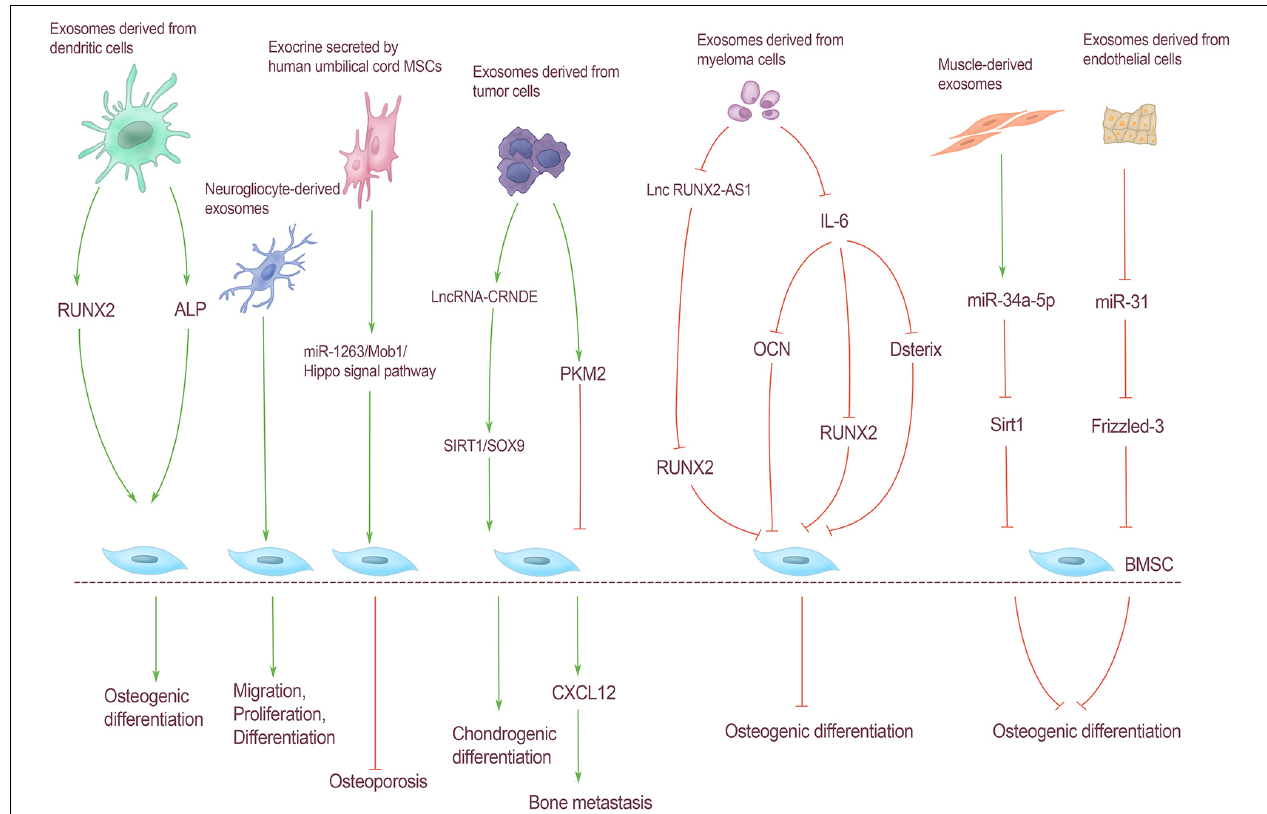
FIGURE 3 | Regulation of BMSCs by exosomes from extra-skeletal organs. Exosomes derived from dendritic cells increased Runx2 expression and ALP activity, and promoted osteogenic differentiation of BMSCs. Neurogliocyte-derived exosomes can promote the migration, proliferation and differentiation of BMSCs. Exosomes secreted by human umbilical cord MSCs can reduce the apoptosis of BMSCs through the miR-1263/Mob1/Hippo signal pathway, and can effectively prevent osteoporosis. Exosomes derived from tumor cells lncRNA-CRNDE can regulate the chondrogenic differentiation of BMSC through SIRT1/SOX9. Exosomes derived from tumor cells act on BMSCs through PKM2, resulting in CXCL12 production in BMSCs, thereby promoting bone metastasis of tumor cells; myeloma cells can directly inhibit RUNX2 by releasing exosomes carrying lnc RUNX2-AS1 through paracrine action on BMSCs, thus inhibiting BMSCs osteogenic differentiation. IL-6 carried by exosomes derived from myeloma cells could inhibit bone differentiation of BMSCs by down-regulating the expression of Runx2, OCN, and Osterix. The expression of miR-34a-5p in muscle-derived exosomes was significantly increased, which could reduce Sirt1 expression and inhibit osteogenic differentiation. Exosomes derived from endothelial cells contain miR-31 into bone through blood circulation and act on BMSCs. Osteoblast differentiation was inhibited by inhibiting Frizzled-3 expression.